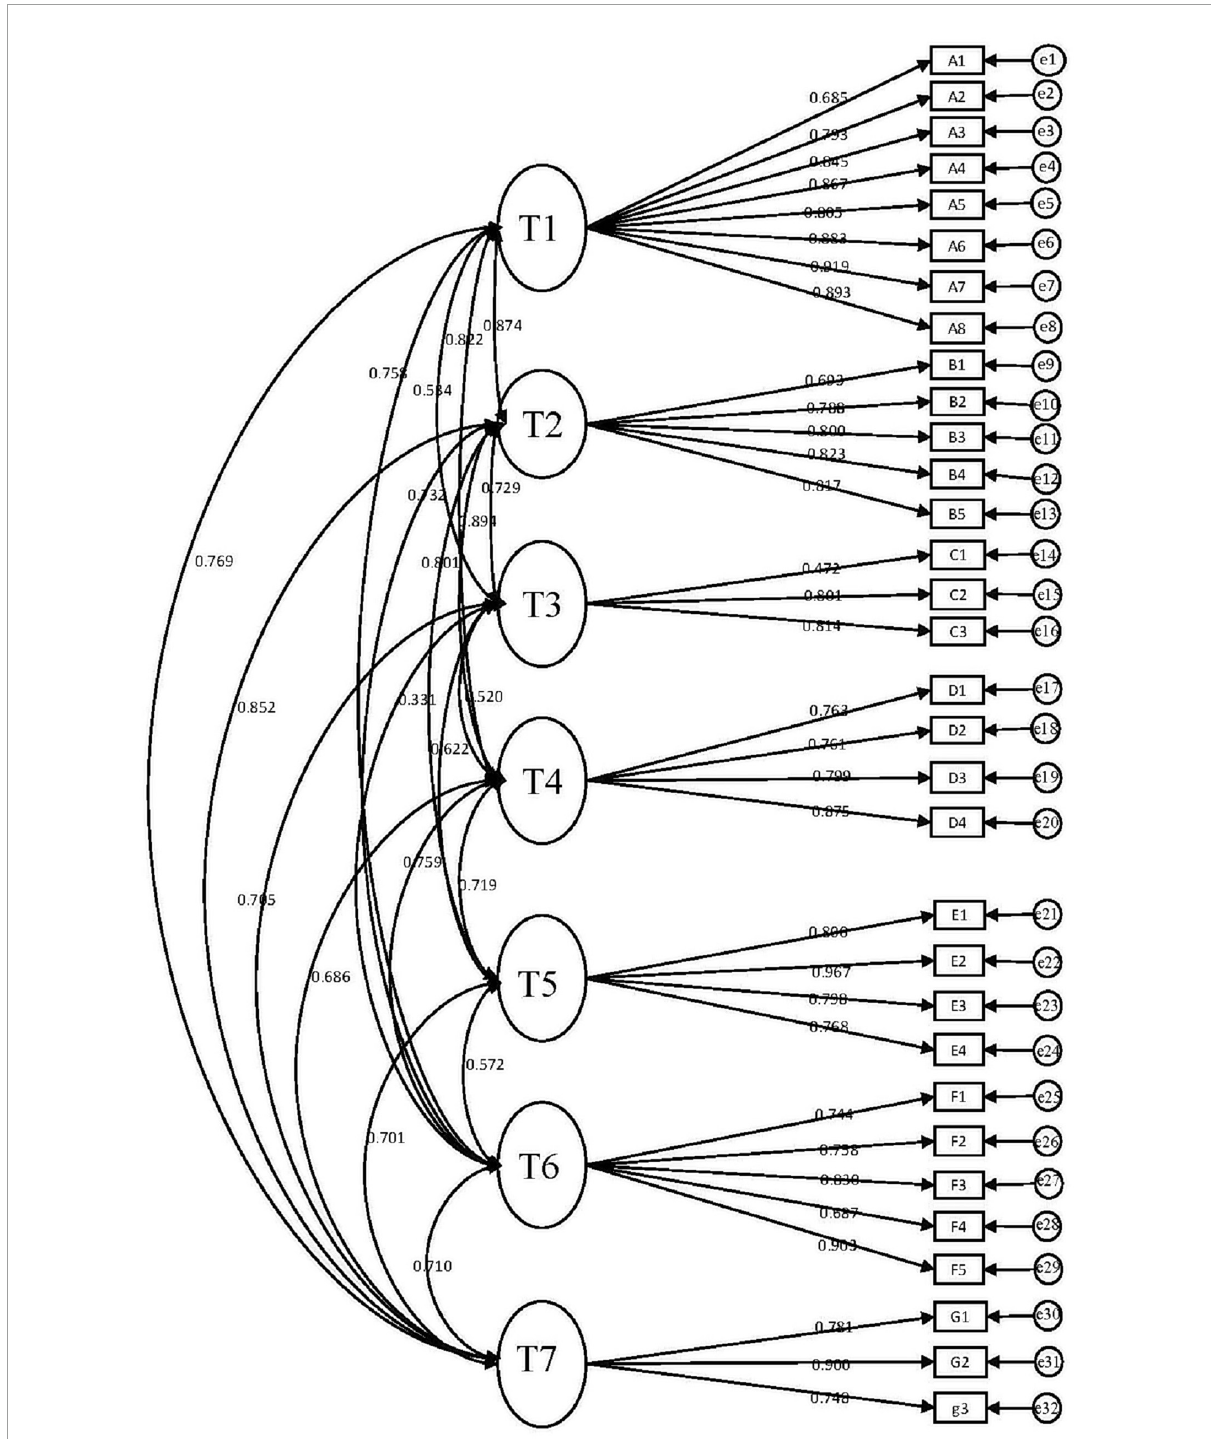
FIGURE1 Confirmatory factor analysis model. T1, translation classroom boredom; T2, under-challenging task boredom; T3, powerpoint presentation boredom; T4, homework boredom; T5, teacher-dislike boredom; T6, general learning trait boredom; T7, over-challenging or meaningless task